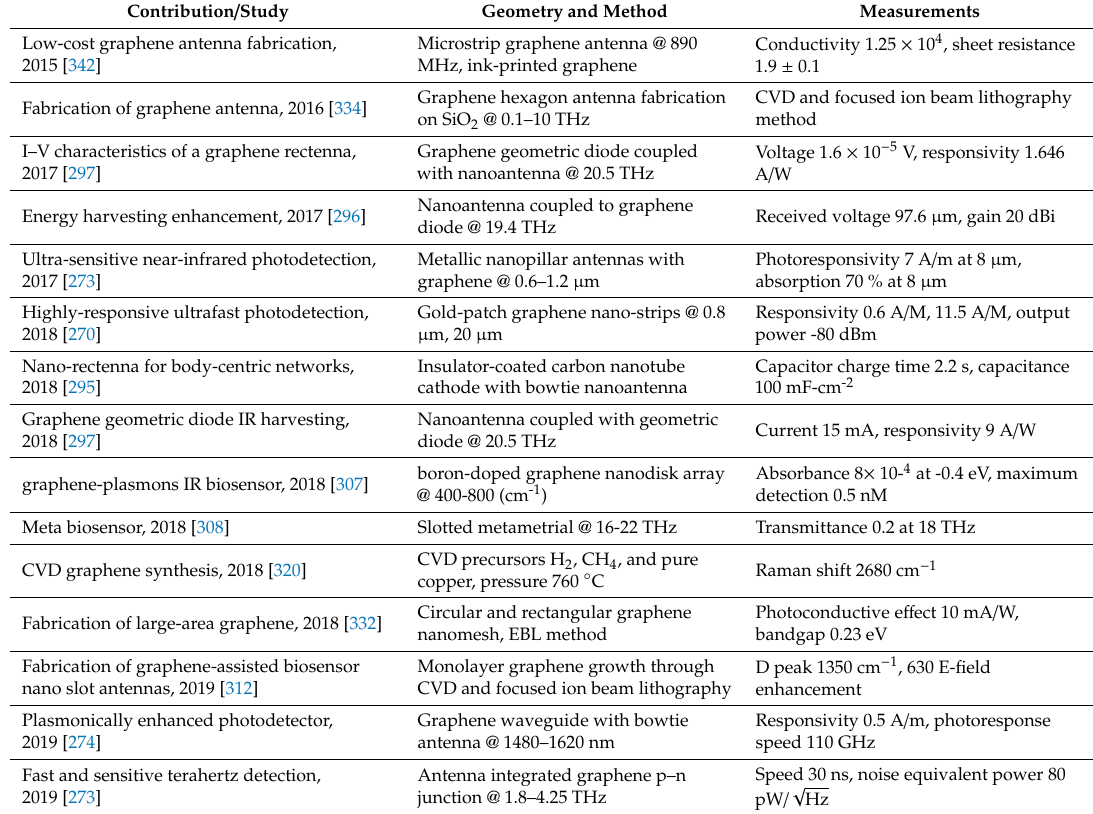
Table 4. Summary of the literature discussed in Sections